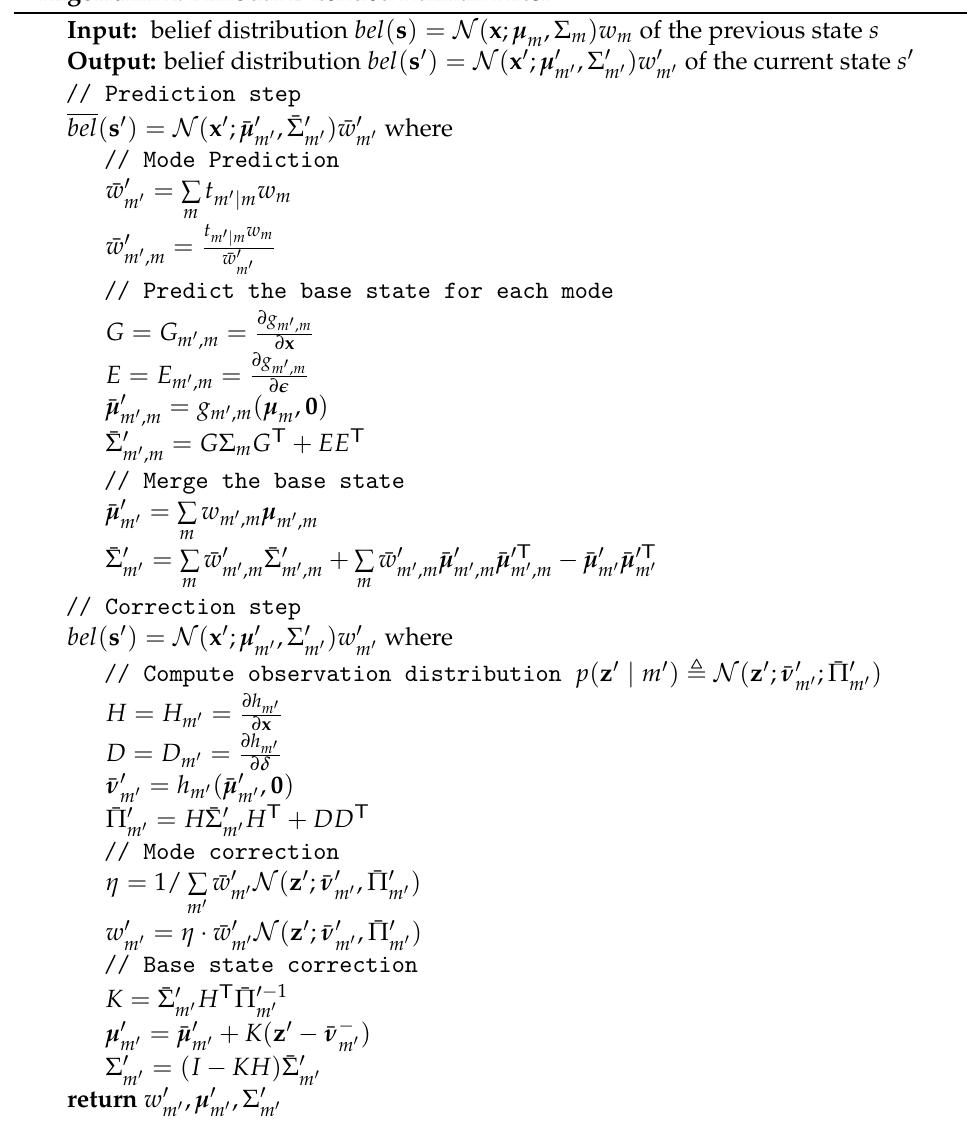
Algorithm 2: Bimodal Extended Kalman